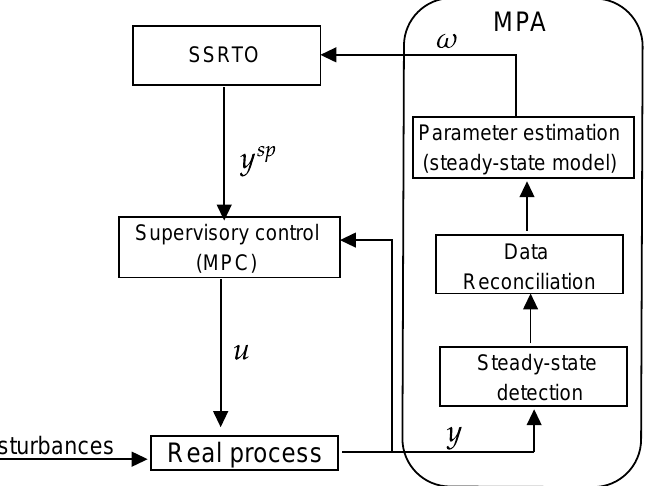
Figure 5. The classical two-layer approach in the industry. The steps of SSRTO with model parameter adaptation and model predictive